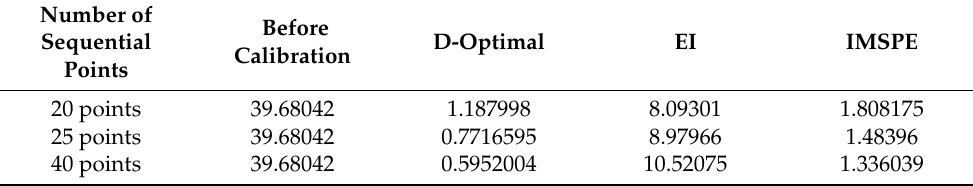
Table 2. The results for MSPE l .